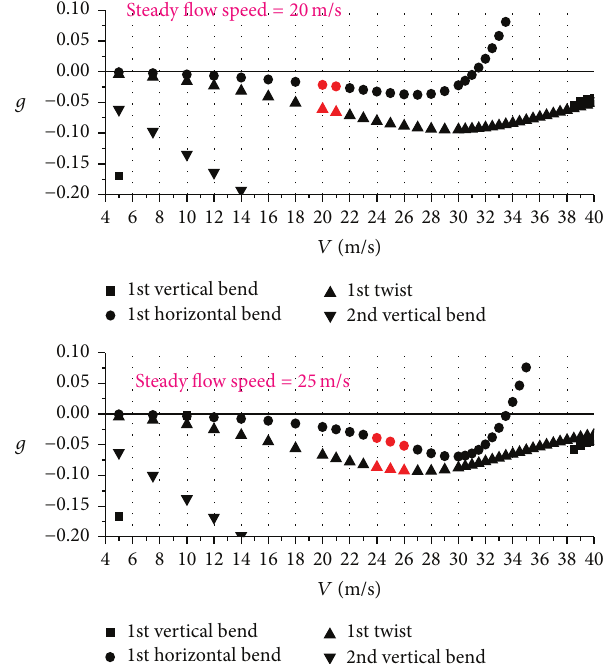
Figure 19: Predicted flutter speed under two flight cases.